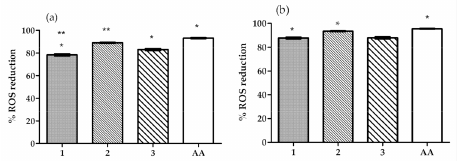
Figure 1. Effect of the OIBPE on the reduction of reactive oxygen species (ROS) formation (%) in HaCaT cells exposed to ( a ) hydrogen peroxide, or ( b ) UVB light for 15 min. An ascorbic acid (AA) solution (1 mg/mL) was used as positive control. Results are mean ± SD, n = 9 (*; ** p <